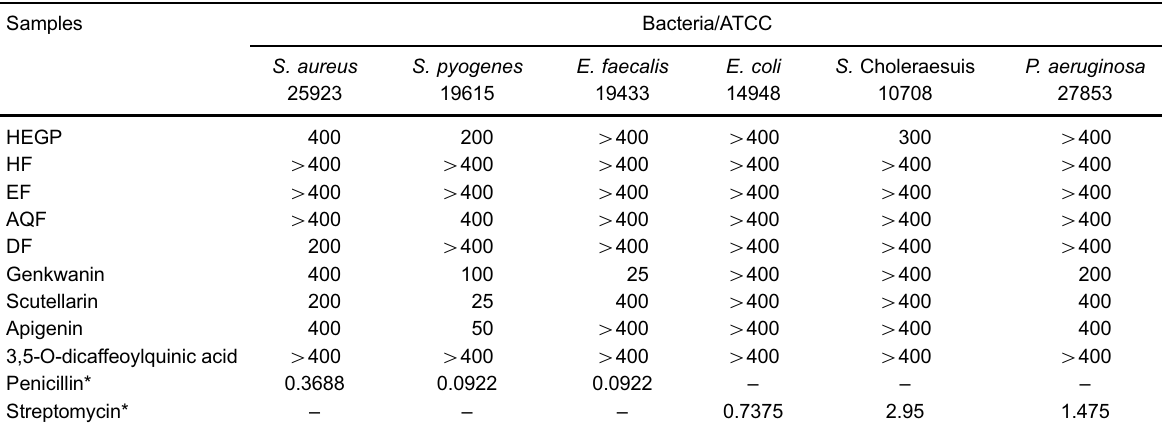
Table 2. Antibacterial potential of the Gochnatia pulchra plant extract, fractions, and isolated compounds as indicated by the minimum inhibitory concentration (MIC; m g/mL) against pathogenic microorganisms.